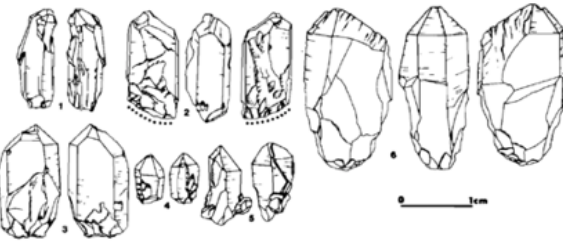
Figure 2. Collection of quartz crystals from the Acheulian site of Singi Talav. From reference 18. (D’Errico).